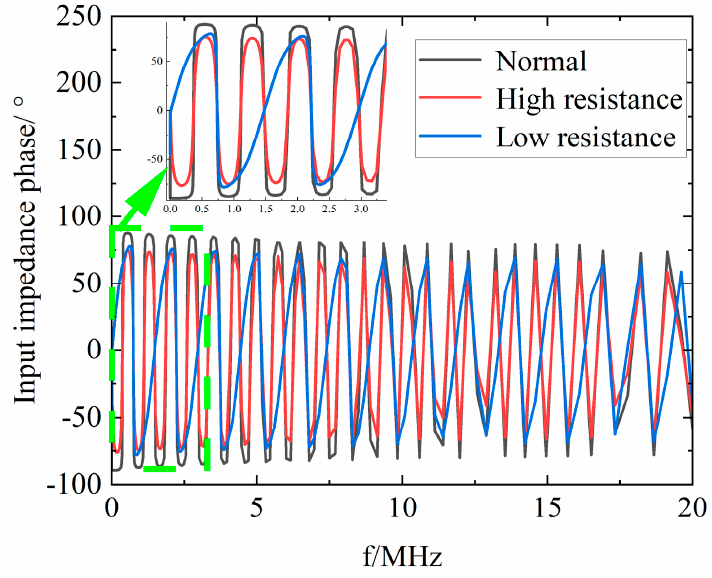
Figure 7. Headend input impedance phase spectrum of normal operation, high resistance, and low